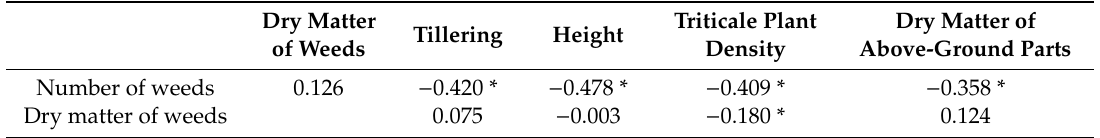
Table 6. Spearman’s correlation coefficients for weed infestation indices and morphological and structure parameters of the canopy of winter triticale (total for all cultivars and years of study, n = 120